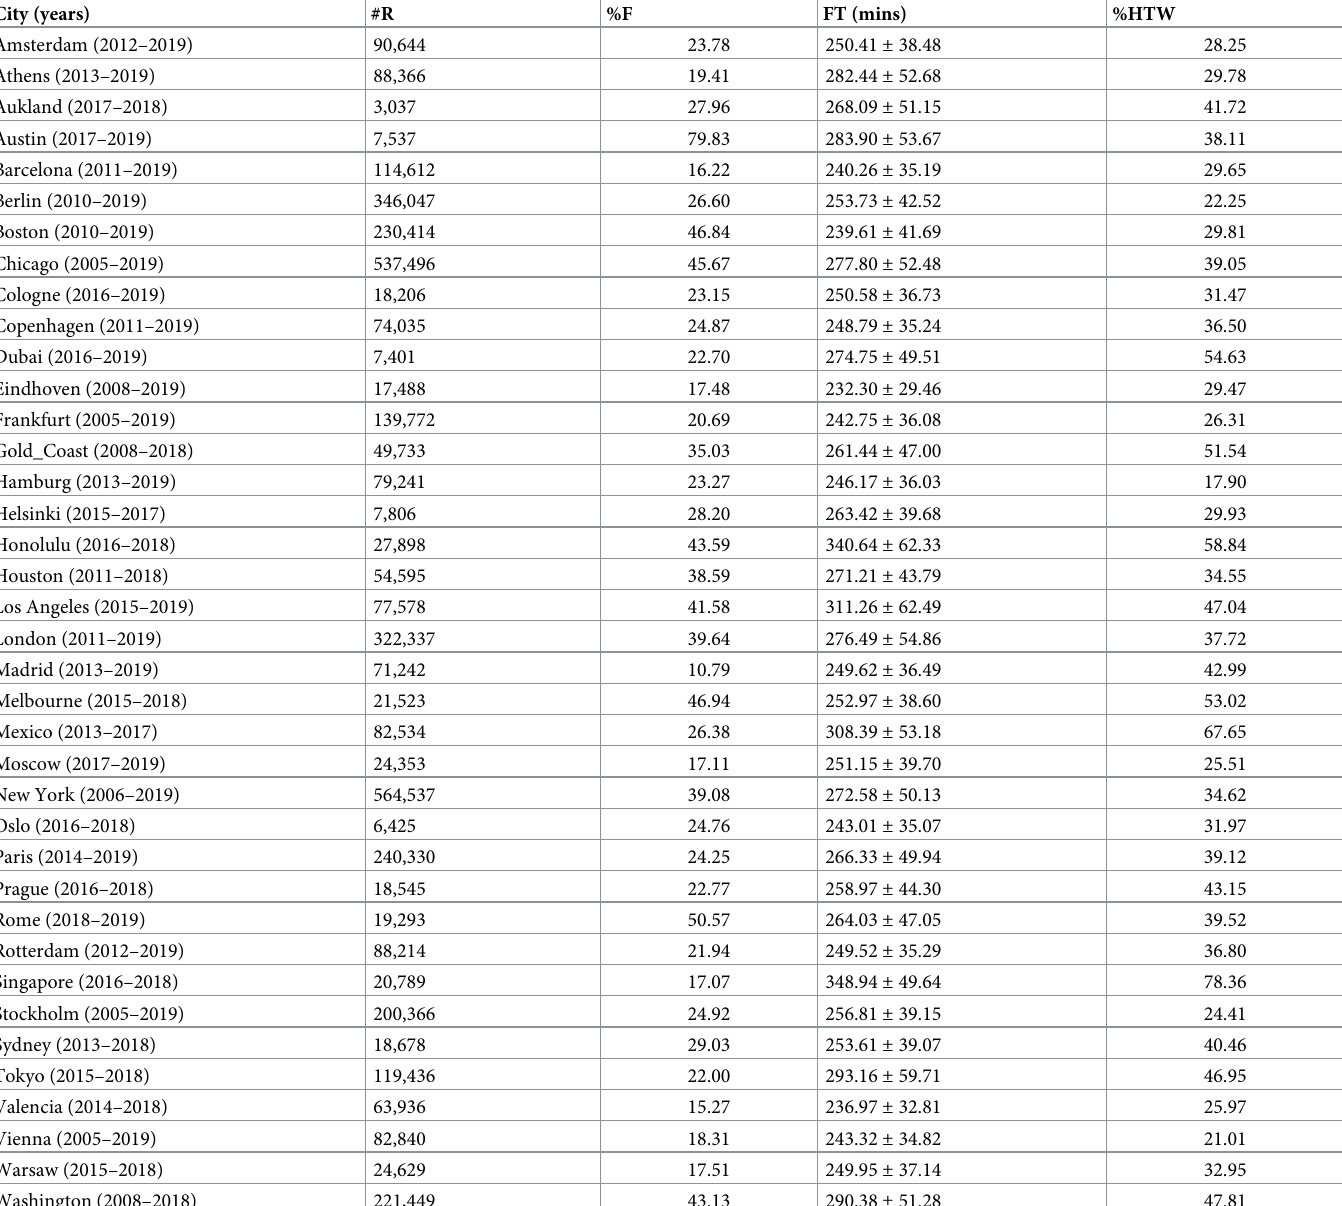
Table 1. A summary of the original dataset by city/race showing the city name and years for which there are data, the number of runners (# R ), the percentage of female runners (% F ), the average finish-time ( FT ) and the percentage of runners hitting the wall (% HTW ) based on the operational defintion adopted here. City (years)